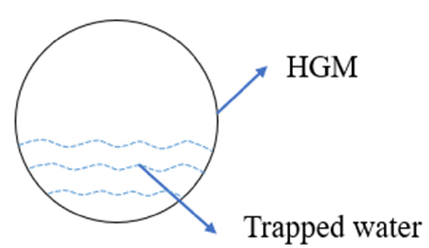
Figure 8. TGA results of HGM1 specimens.